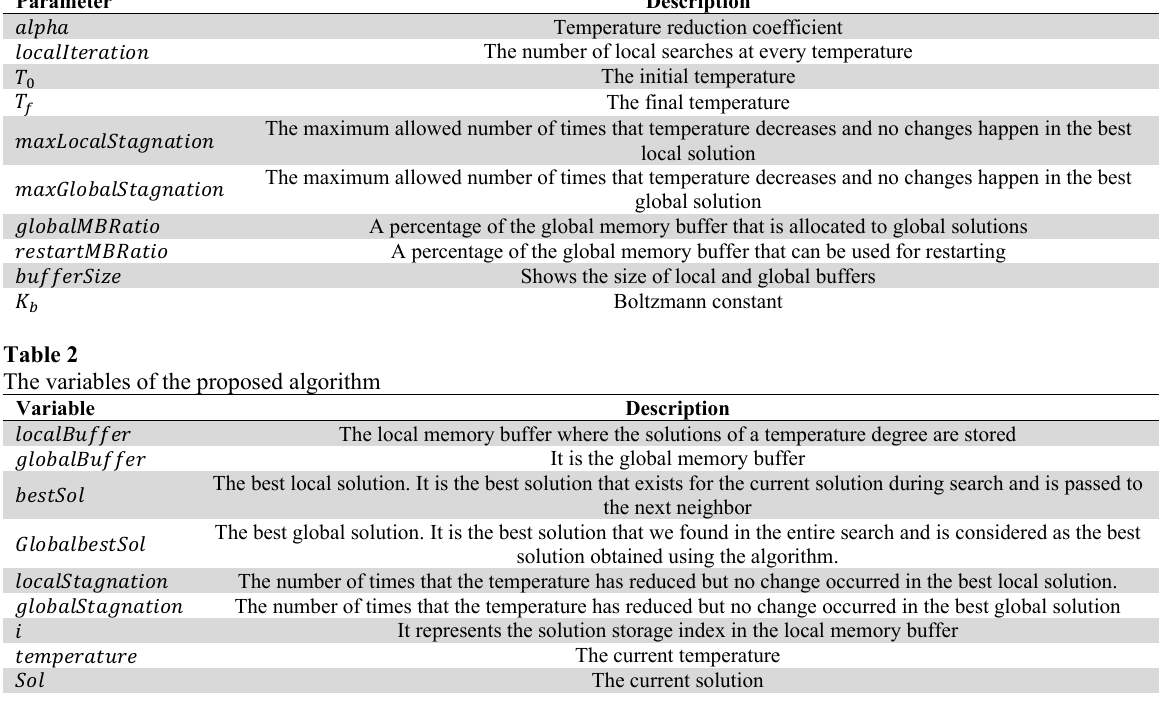
The parameters of the proposed algorithm Parameter